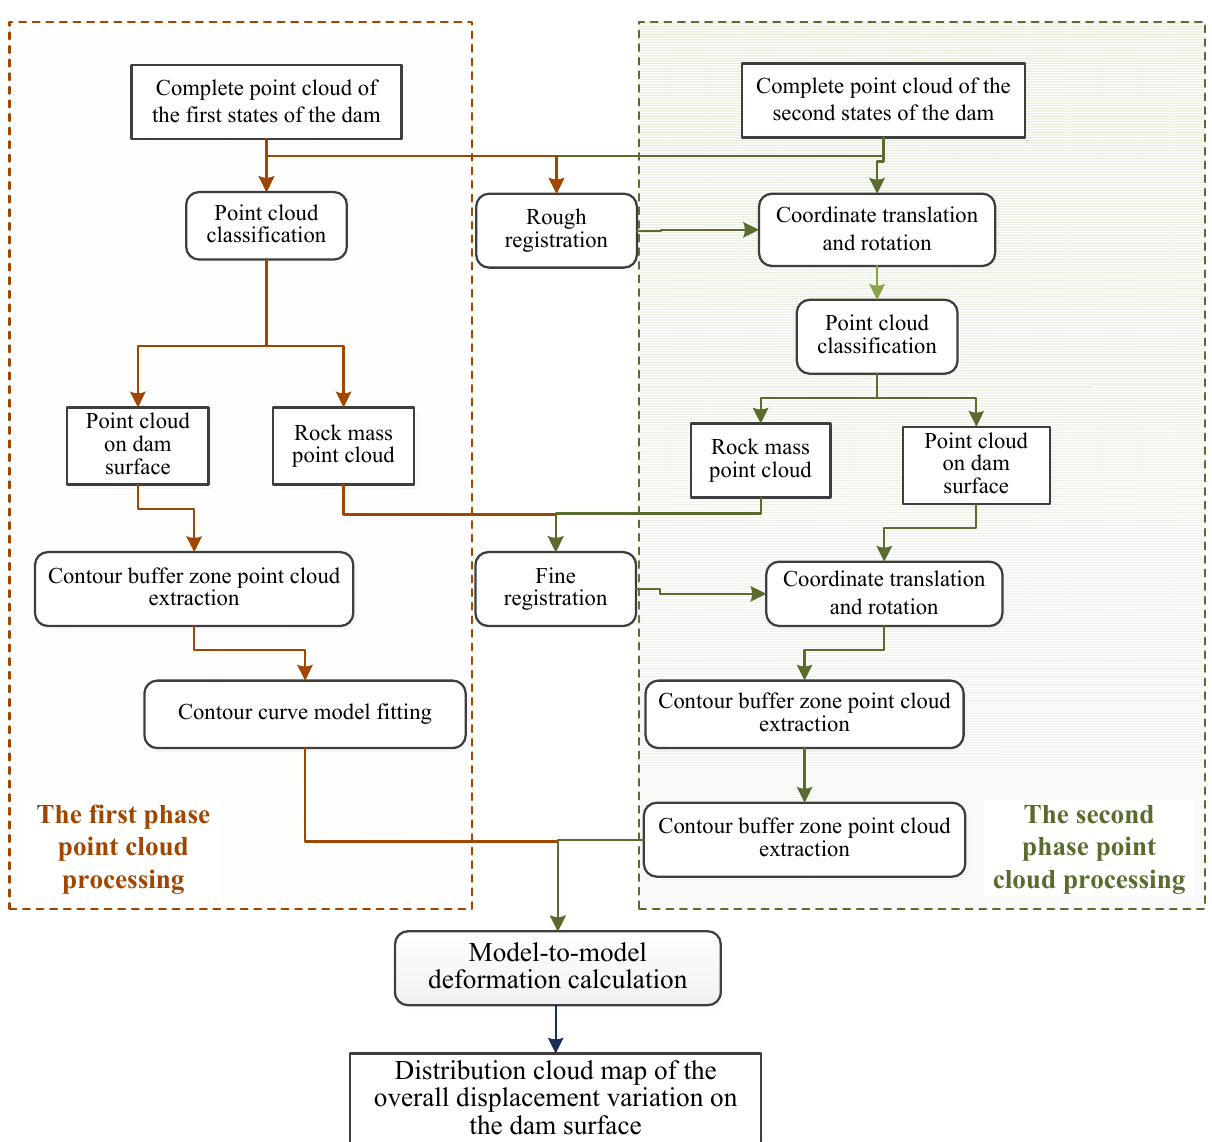
Figure 1. Flow chart of dam displacement variation analysis based on the 3D point cloud.